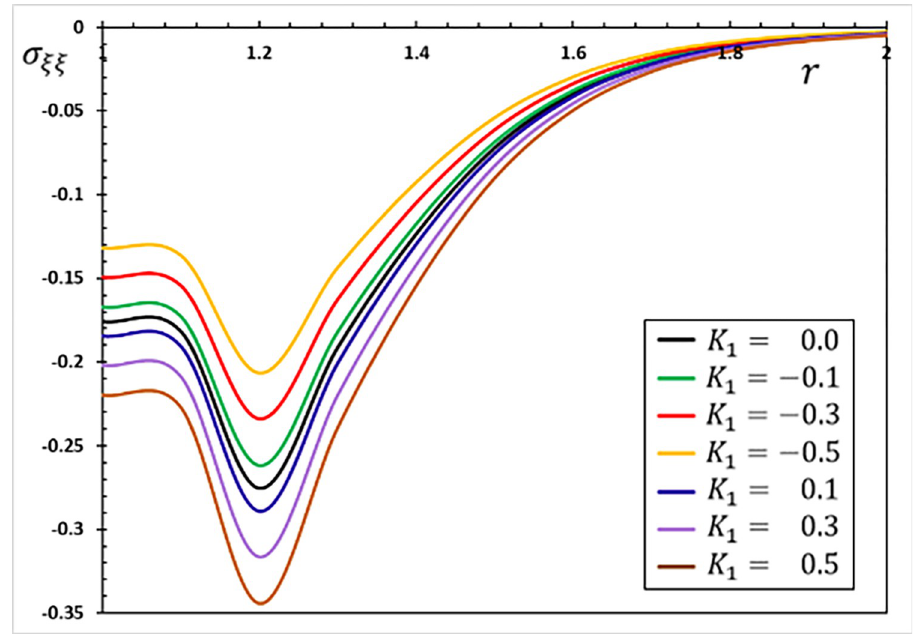
Fig 4. The hoop stress variation σ ξξ for different values of the parameter K 1